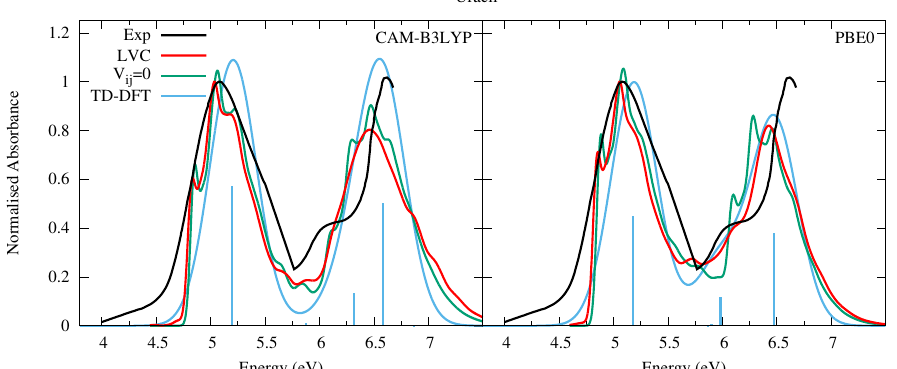
Figure 2. Absorption spectra of Uracil from the LVC model (red), without inter-state coupling (green), TD-DFT calculations with stick spectra (blue), and experimental data (black) [52]. Cusp in experimental spectrum at 5.75 eV due to gap in data from 5.5 eV to 5.75 eV as separate spectra obtained for lower energy and upper energy bands, recorded at different temperatures (501 K and 439 K, respectively). Low energy peak from experiment and LVC spectra normalised to 1, with other calculated spectra normalised with the same value as LVC spectra. CAM-B3LYP spectra red-shifted by 0.3 eV, PBE0 by 0.15 eV. LVC spectra broadened with Gaussian HWHM 0.04 eV, TD-DFT with HWHM 0.25